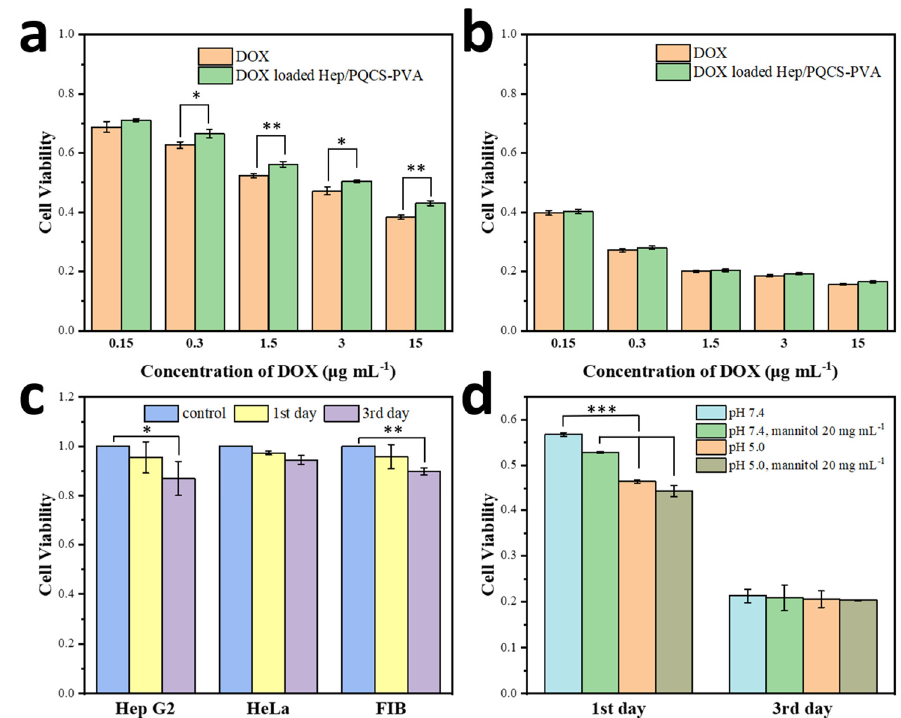
Figure 6. Cell viability measured by MTT assay. Cell viability of DOX-loaded Hep/PQCS-PVA NPs and free DOX toward Hep G2 cells at ( a ) 1st day and ( b ) 3rd day. ( c ) Cell viability of empty Hep/PQCS-PVA NPs toward Hep G2 cells, HeLa cells, and FIB cells. ( d ) Cell viability of DOX-loaded Hep/PQCS-PVA NPs toward Hep G2 cells with or without treatment with 20 mg mL − 1 mannitol at pH 7.4 or pH 5.0. *: p < 0.05, **: p < 0.01, ***: p < 0.001.